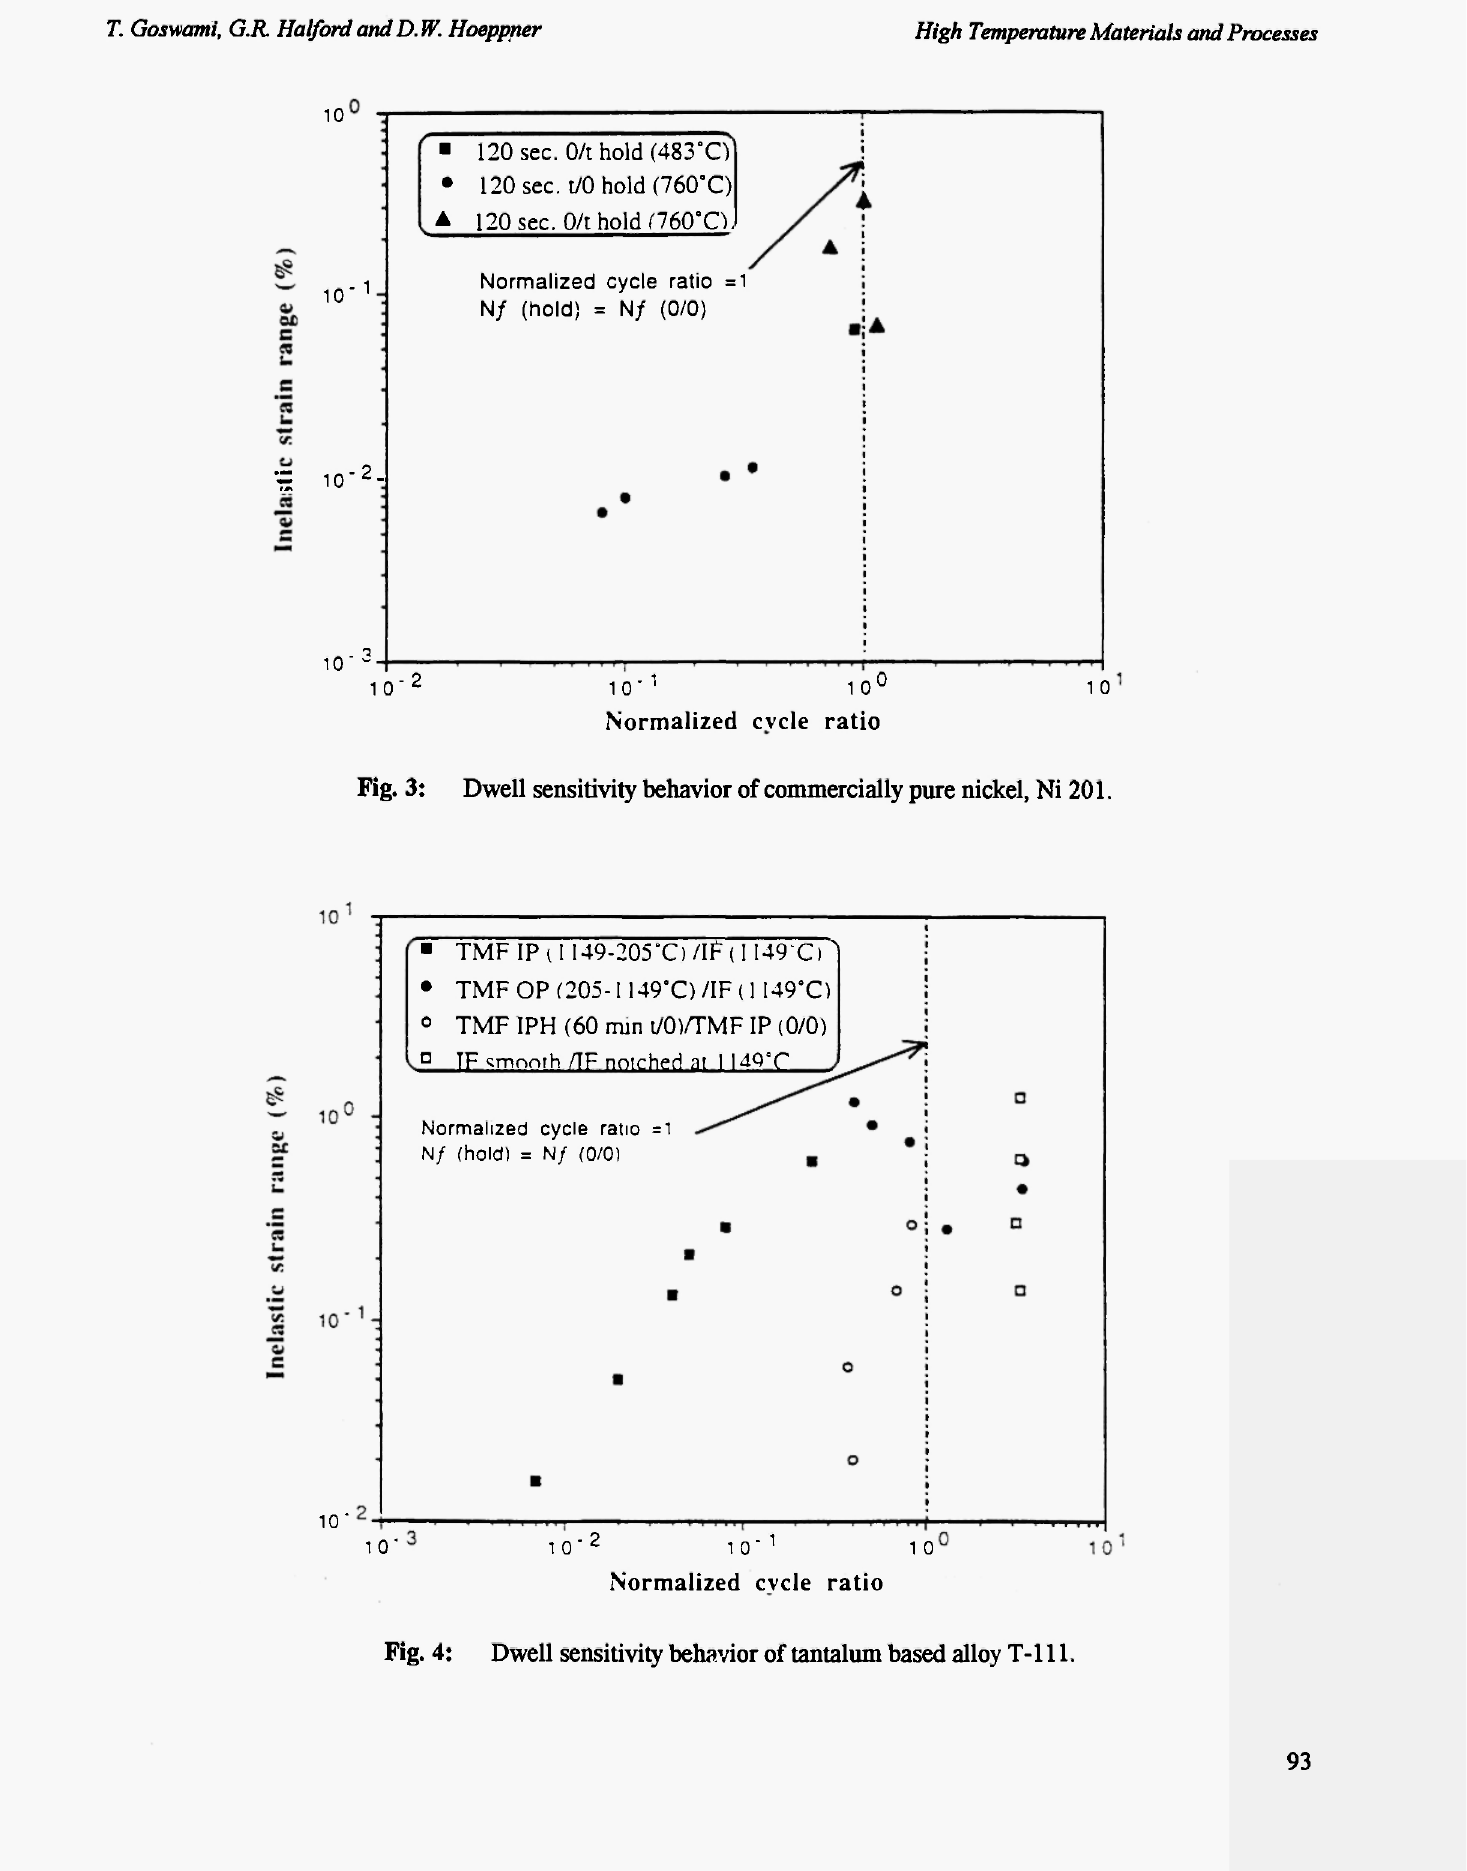
Fig. 3: Dwell sensitivity behavior of commercially pure nickel, Ni 201.